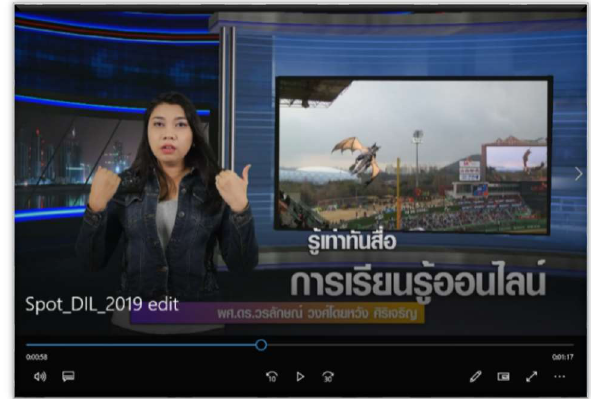
Figure 3. SMART MOOC, DIL literacy Module 3 Information technology causes the economic system to change from the local system to the global